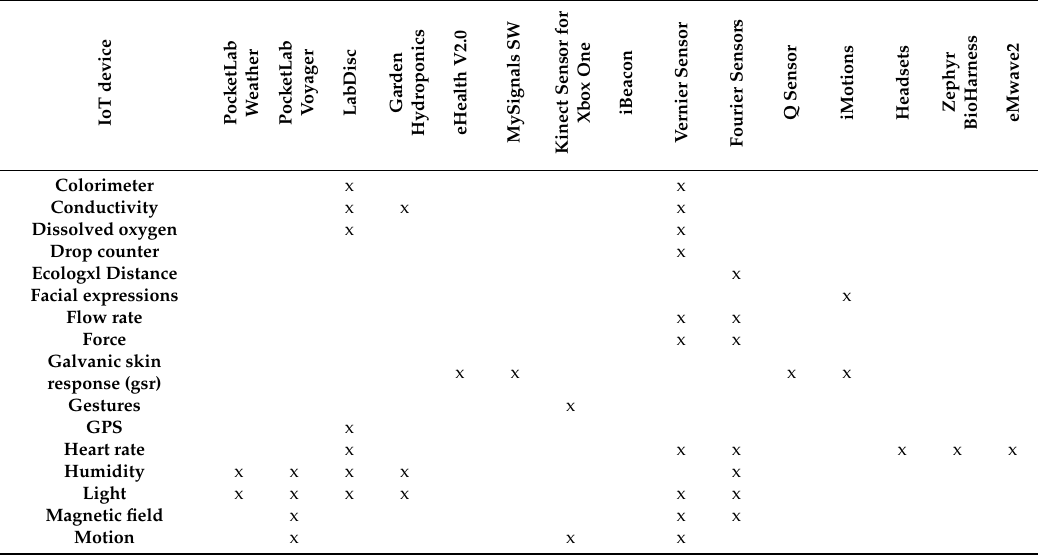
Table 2. An extract of the table of IoT devices charted on the basis of the Internet